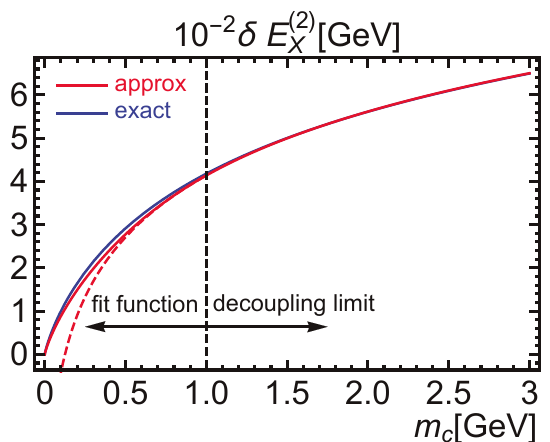
Figure 1. Finite charm quark mass corrections to the (cid:7)(1 S ) mass at O ( " 3 ) in the pole scheme. We take the values m b = 4 : 2 GeV, (cid:22) = 2 GeV and (cid:11) ( n f =5) s ( m Z ) = 0 : 118. The blue line corresponds to the exact result, while the red solid line is the approximation described in the text. The red dashed line shows the decoupling limit